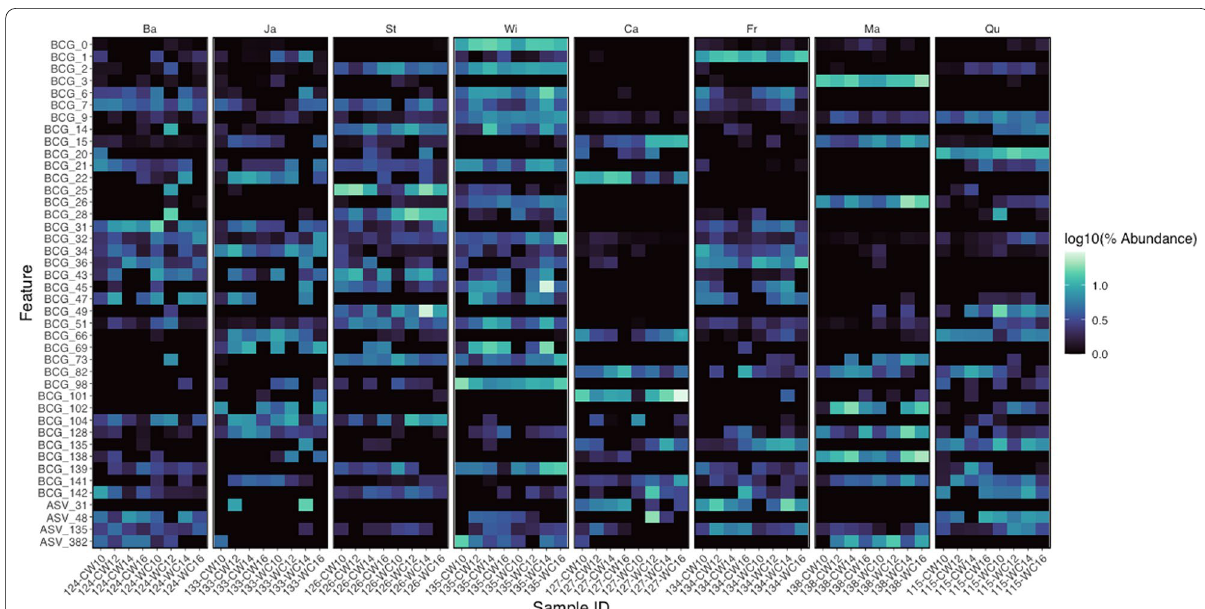
Fig. 4 Differentially abundant bacterial co‑abundance groups (BCG) and ungrouped amplicon sequenc variants (ASV) by horse. Features (BCG and ASV) were dentified as differentially abundant (W 704) across horses using Analysis of Composition of Microbes (ANCOM) in Qiime 2 (v.2020.8). ≥ Individual horses are designated with two‑letter abbreviations and arranged such that each horse is represented by an individual facet grid, with horses on the left‑hand side assigned to the bermudagrass integrated rotational grazing system (n 4) and horses on the right‑hand side assigned = to the crabgrass integrated system (n 4). Sample IDs on the x‑axis are arranged such that the first four samples within each horse represent = transitions from cool‑season grass to warm‑season grass and the final four samples within each horse represent transitions from warm‑season grass to cool‑season grass. Within transitions, samples are arranged from D0 through D6